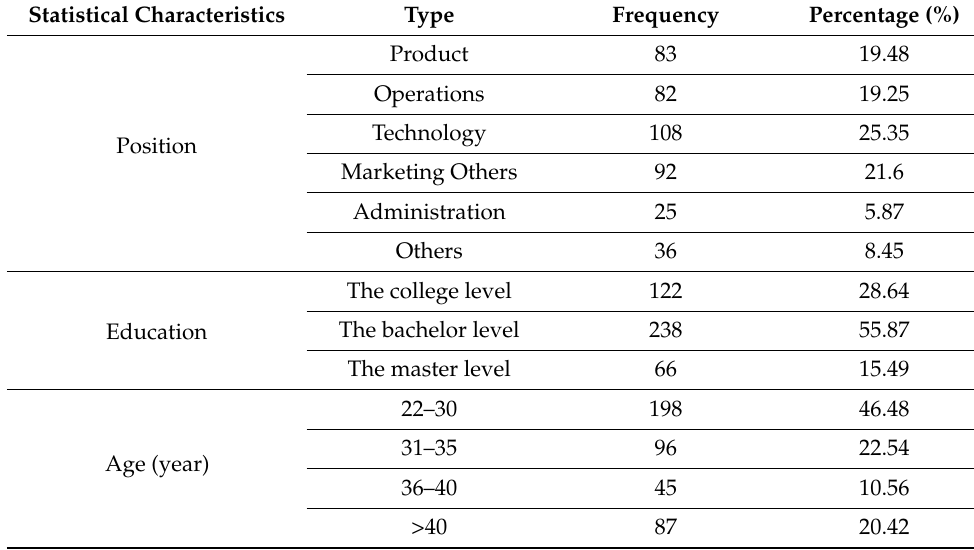
Table 1. The distribution characteristics of the sample.